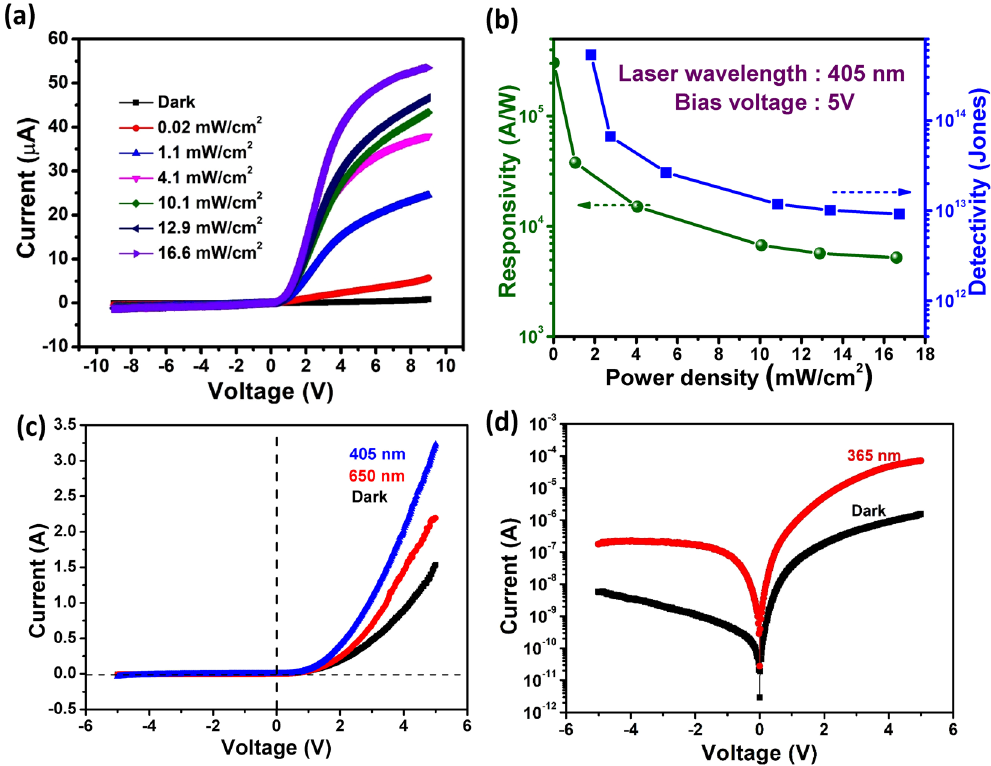
Figure 2. Photoresponse of MoS 2 /GaN heterojunction under illumination with 405 nm laser. ( a ) Linear plot of photoinduced behavior of MoS 2 /GaN heterojunction under different illumination intensities of 405 nm laser source. ( b ) Plots of responsivity and detectivity with light intensity. ( c ) Photoelectrical behavior of device under illumination of 650 nm and 405 nm laser. ( d ) log plot of electrical behavior of the device after exposure to UV light (365 nm).